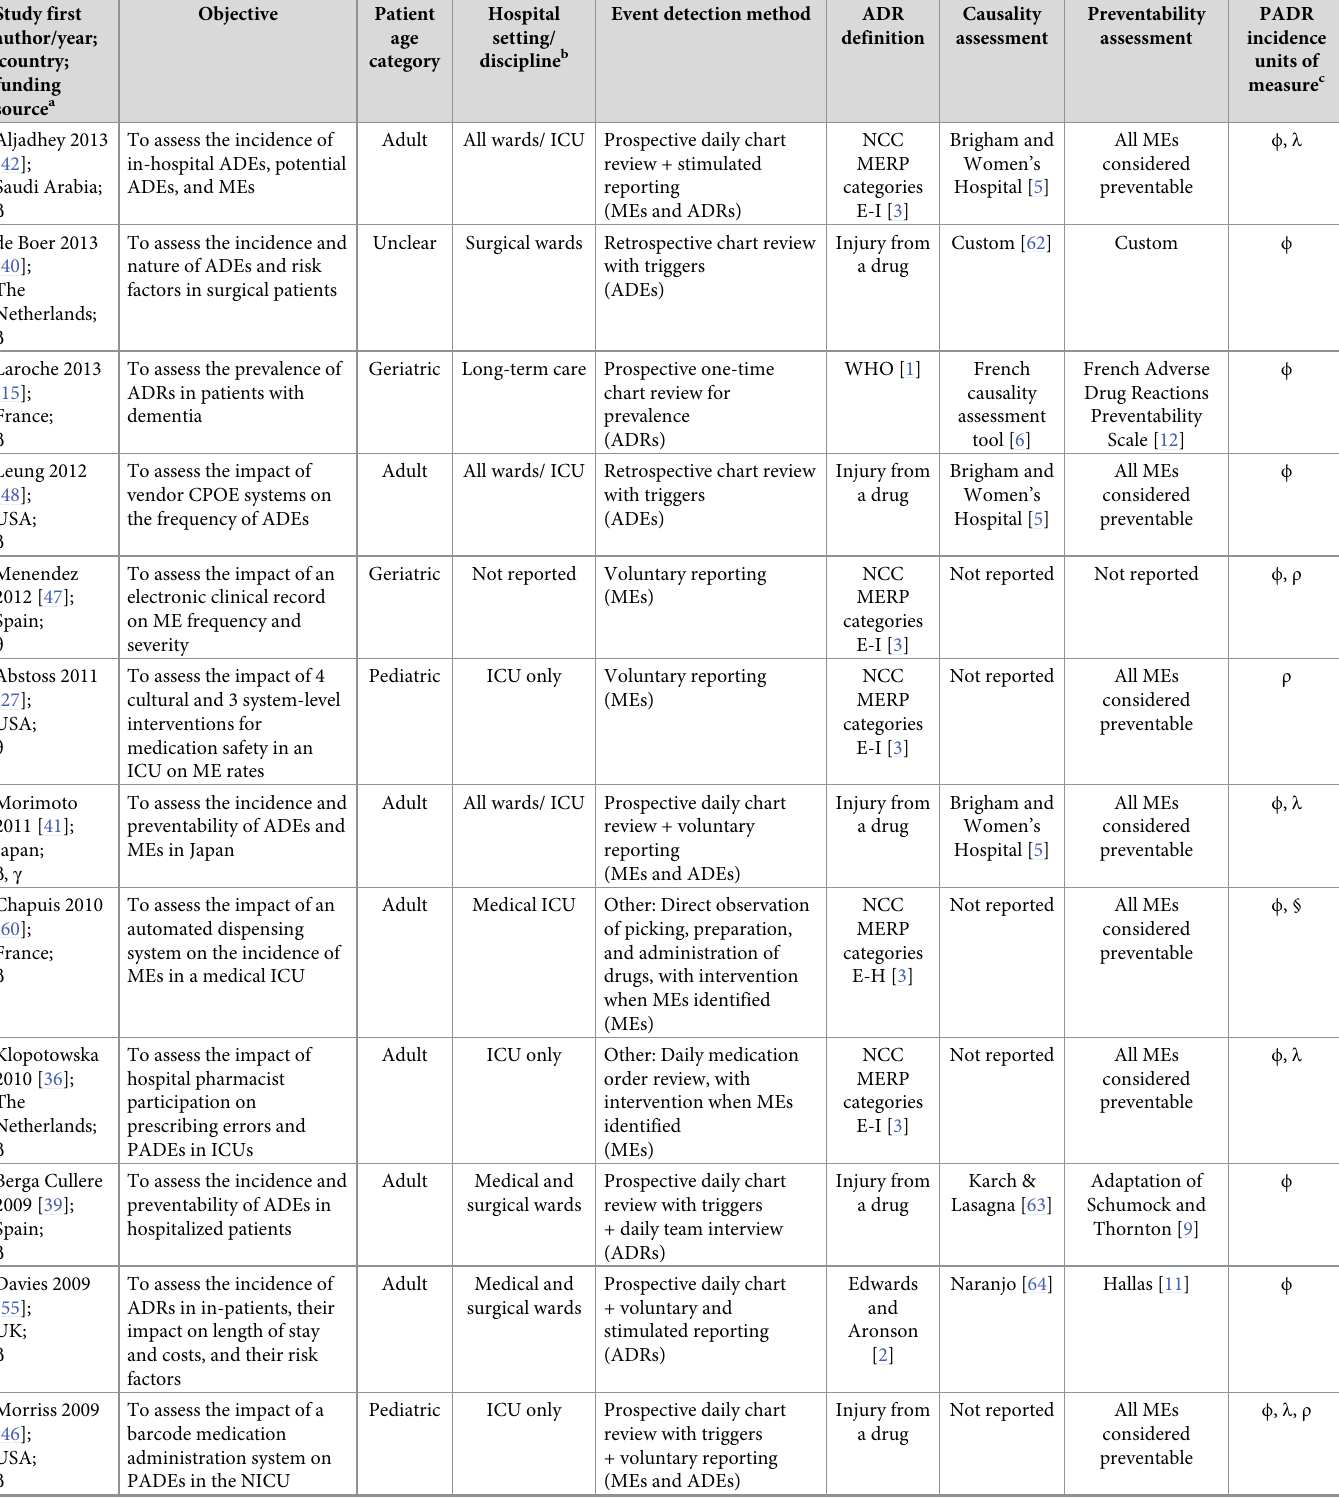
Table 5. Characteristics of the studies included in primary study